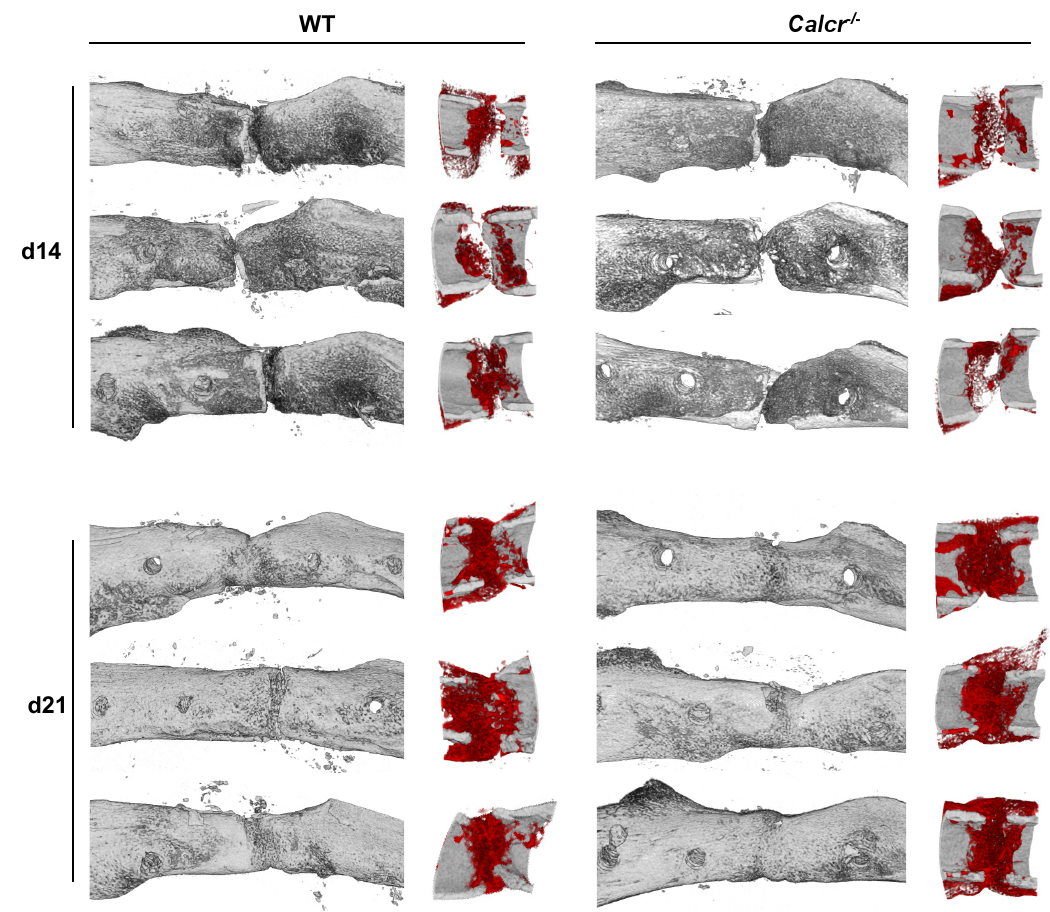
Figure 2. Deficiency in CTR ( Calcr − / − ) does not significantly affect bone regeneration. Representative µ CT images (left column = sagittal overview; right column = sagittal detailed view) of the callus region in WT and Calcr − / − mice at day 14 and day 21 following osteotomy. Three representative images are shown for each group and time point. In the sagittal view, newly mineralized callus is indicated in red, whereas the original bone is displayed in